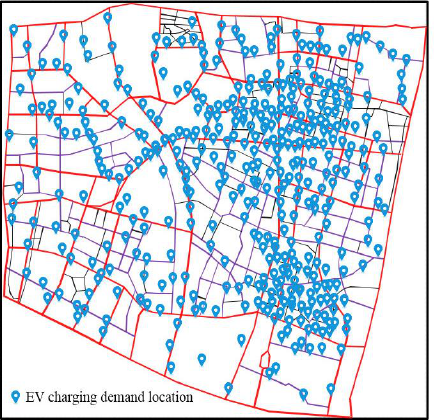
Figure 11. Spatial distribution of vehicles with fast-charging requirements in the peak period.